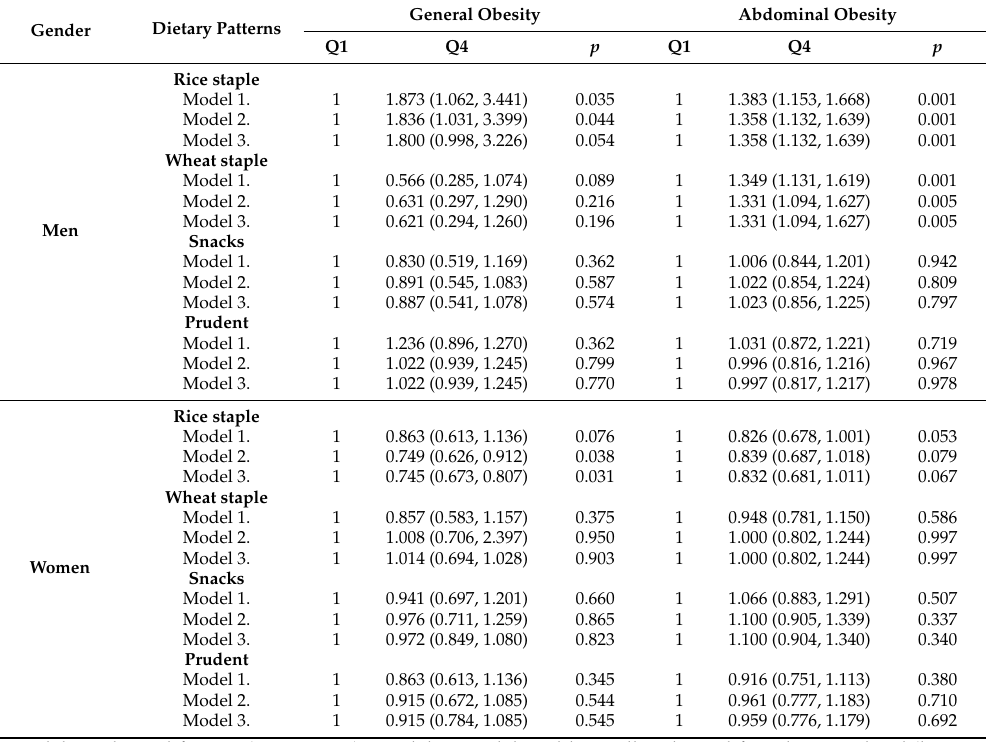
Table 5. Association of dietary patterns with general obesity and abdominal obesity across quartiles of dietary pattern